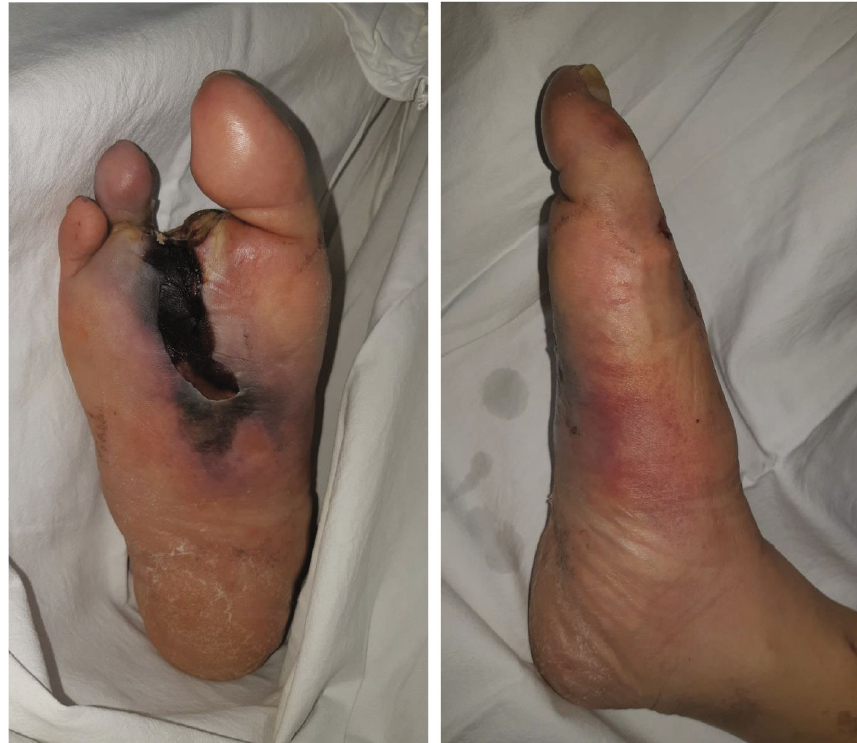
Figure 1: Clinical photographs of the right foot. Active infection and necrosis were limited to the